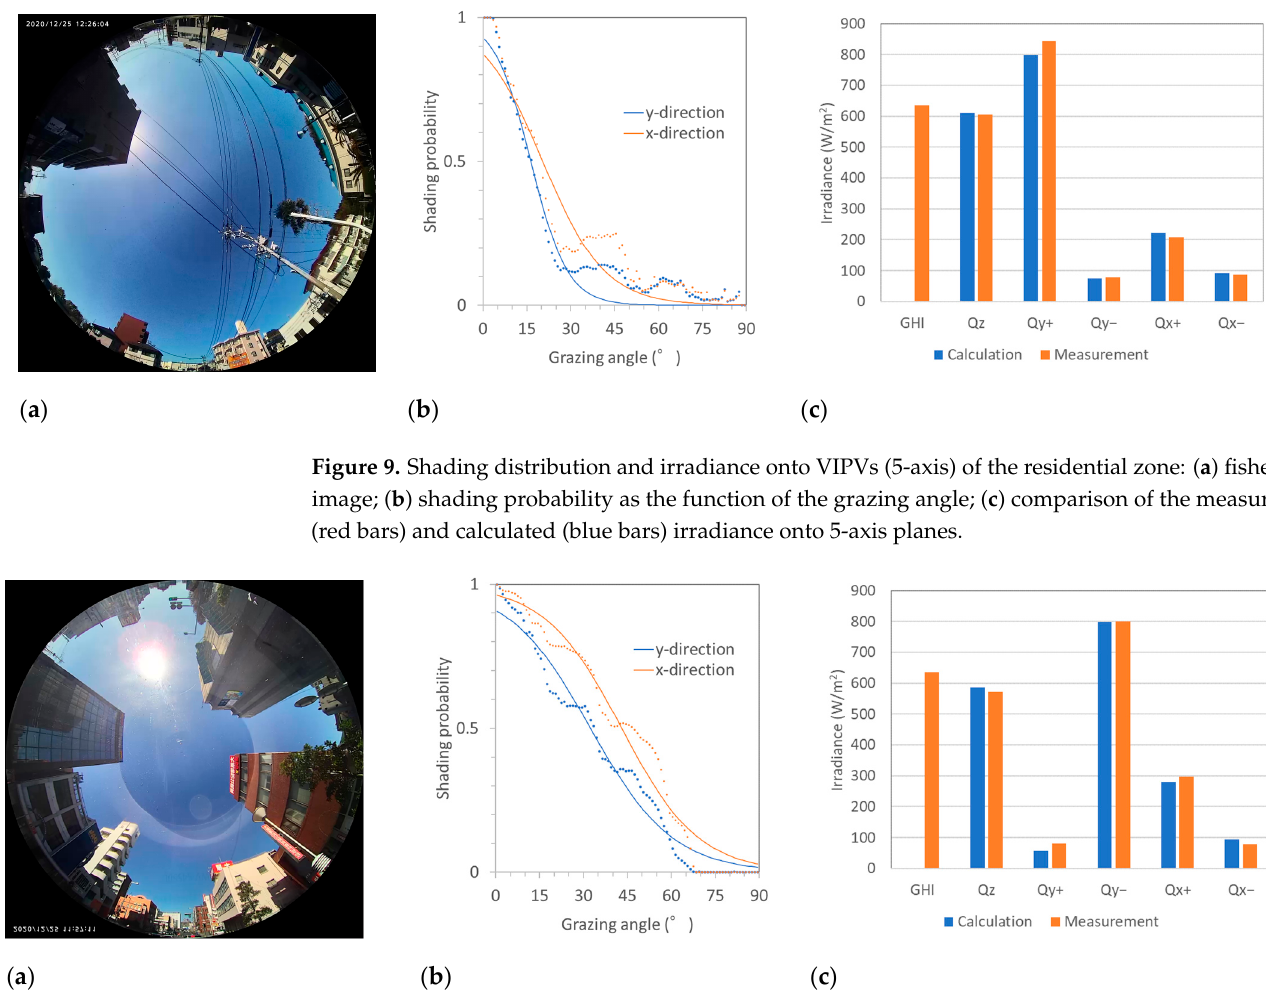
Figure 8. Shading distribution and irradiance onto VIPVs (5-axis) of the open zone: ( a ) fi sheye image; ( b ) shading probability as the function of the grazing angle; ( c ) comparison of the measured (red bars) and calculated (blue bars) irradiance onto 5-axis planes.